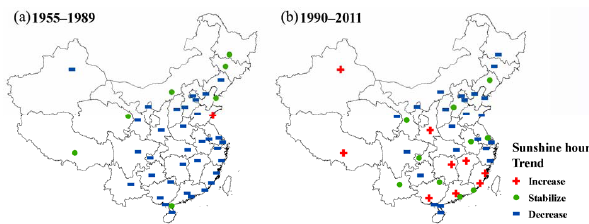
Fig. 3. Spatial patterns of sunshine hour trends over 42 meteorological stations across China for 1955–1989 (a) and 1990–2011 (b) (Wang et al., 2013).